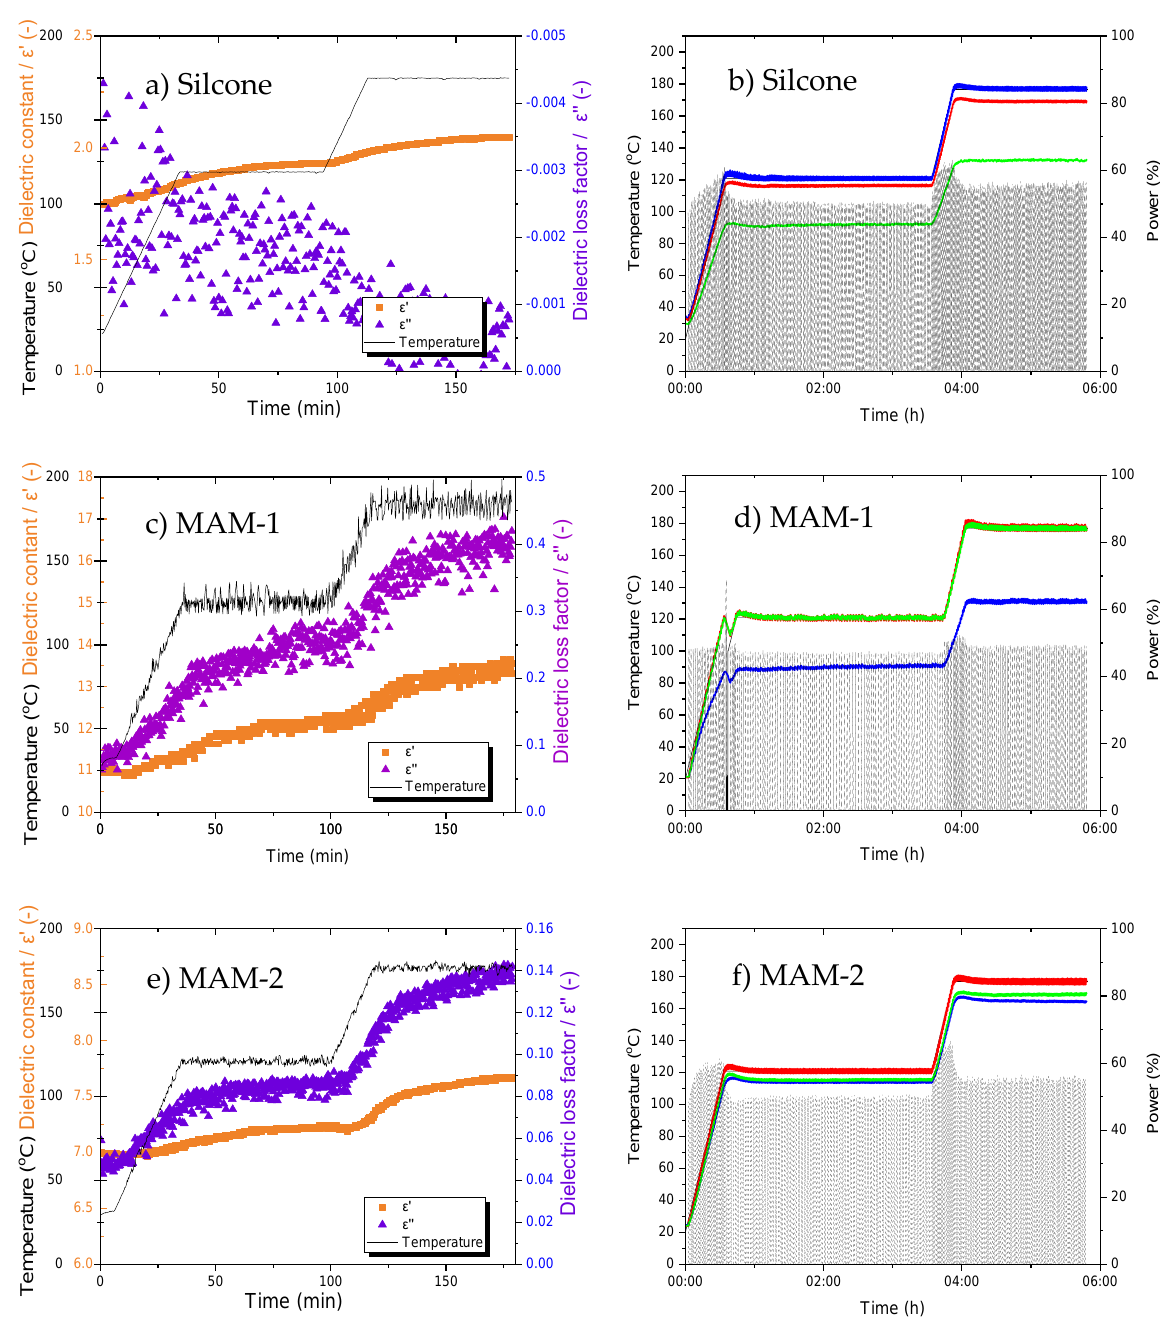
Figure 3 . Dielectric properties and temperature-time-power graphs of ( a , b ) silicone, ( c , d ) MAM-1, and ( e , f ) MAM-2, respectively. The temperature-time-power graphs include the setpoint temperature (black solid), FOT-1 (blue), FOT-2 (red), FOT-3 (green), and power (black dash), where trials were conducted on the microwave test bed. Table 1. Thermal properties of the microwave absorbing materials. Microwave Absorbing Materials (MAMs) Thermal Conductivity/(W/mK) Thermal Diffusivity/(mm 2 /s) 0.36